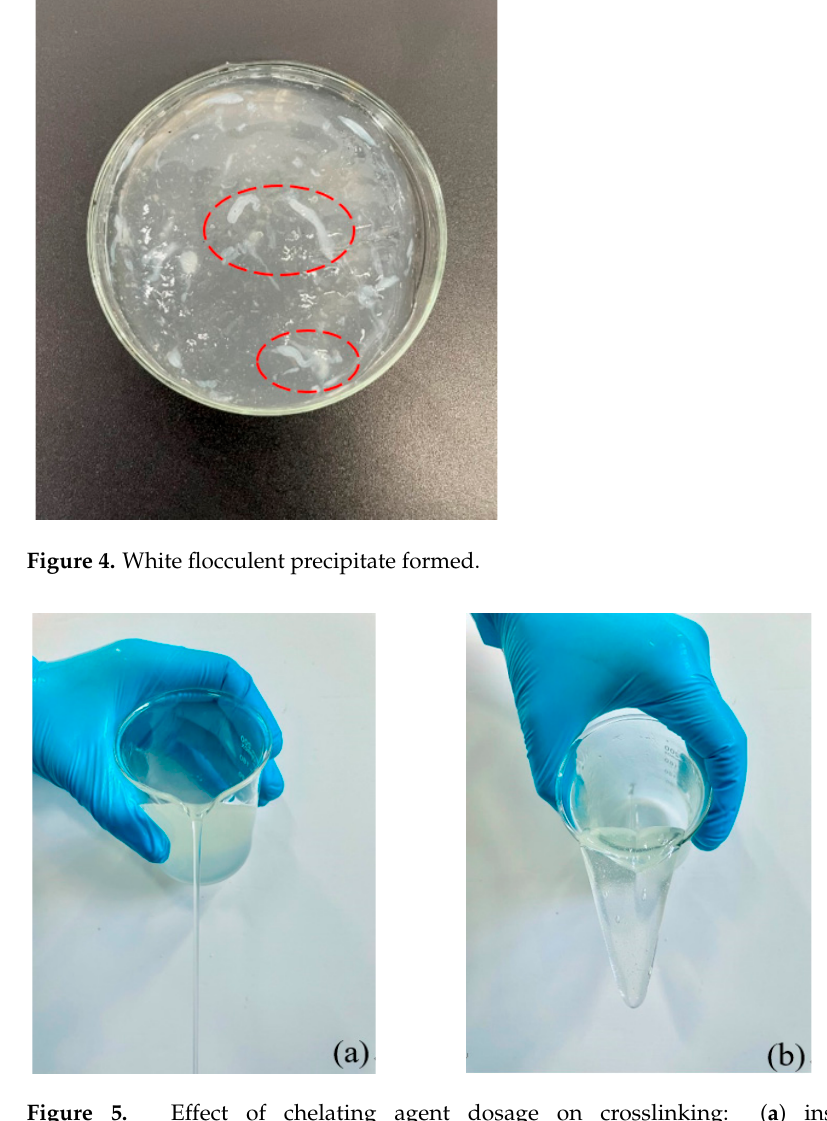
Figure 5. Effect of chelating agent dosage on